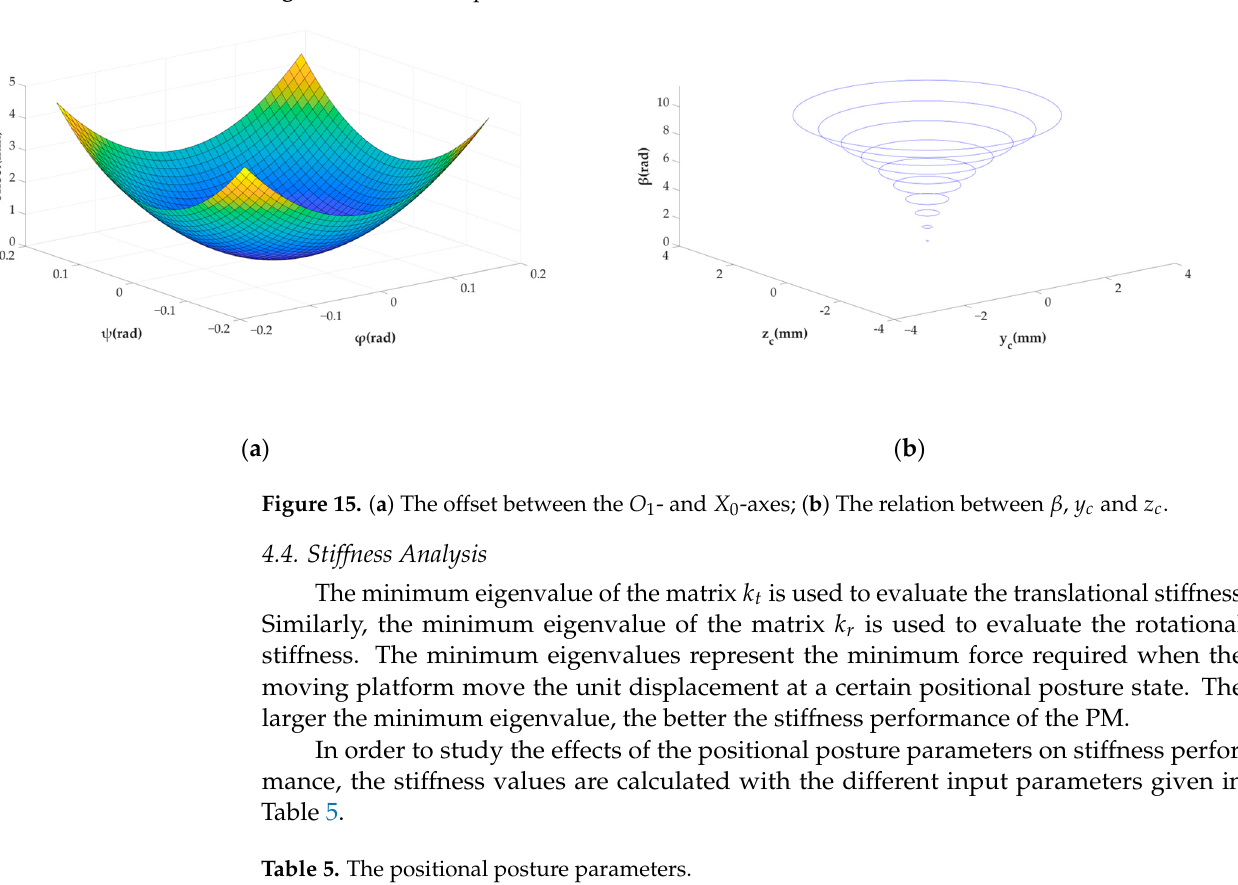
Table 5. The positional posture